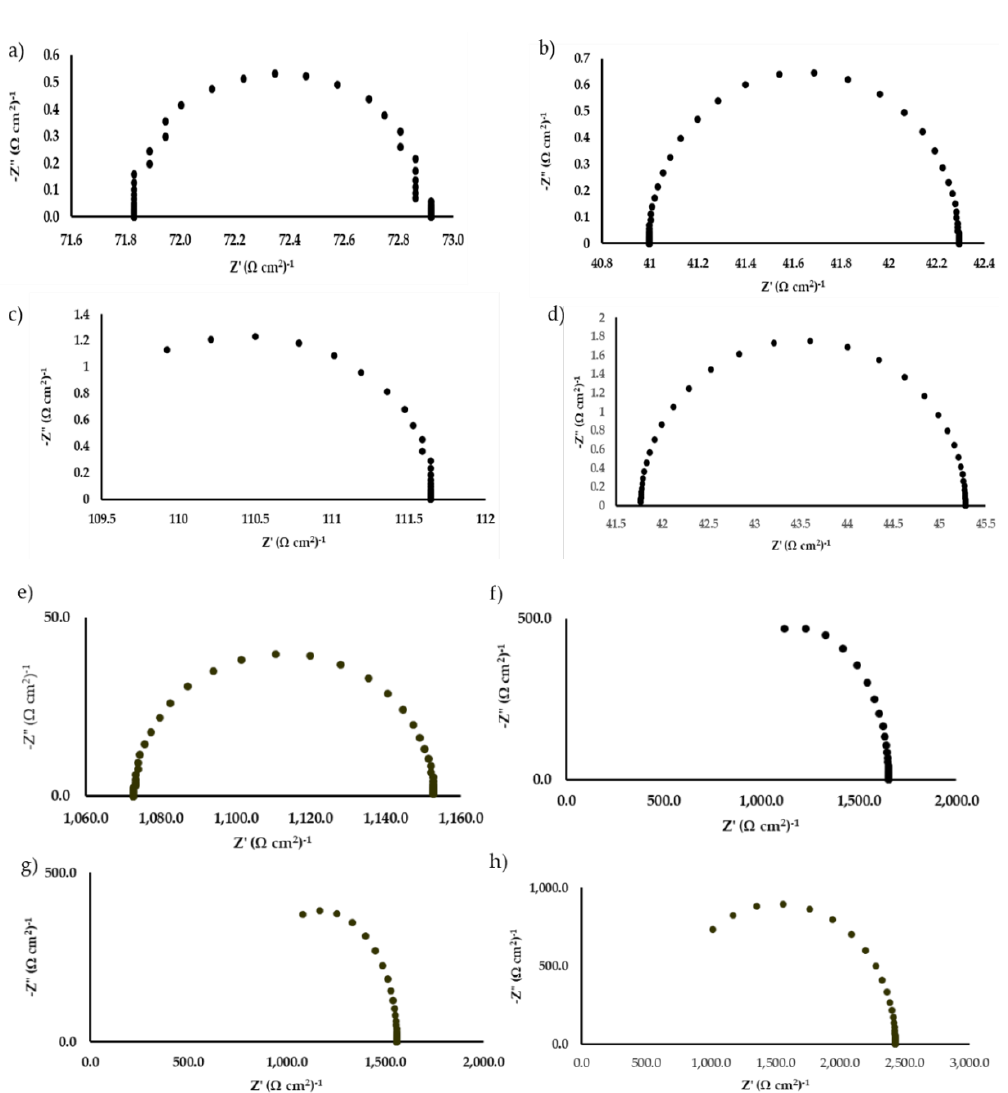
Figure 4. Electrochemical impedance spectra of DCFC at 850 °C for untreated rubber wood and rice husk biochar: ( a ) RW550, ( b ) RW650, ( c ) RW750, ( d ) RW850, ( e ) RH550, ( f ) RH650, ( g ) RH750, ( h ) RH850.